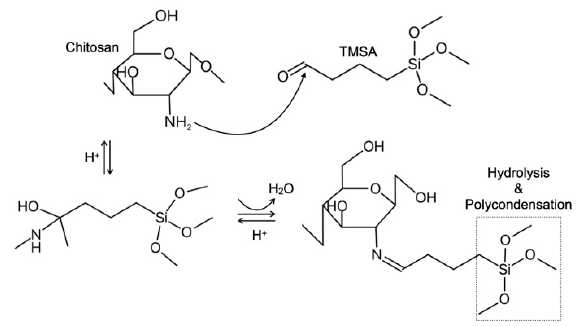
Figure 2. Expected reaction between chitosan and TMSA forming a Schiff base.